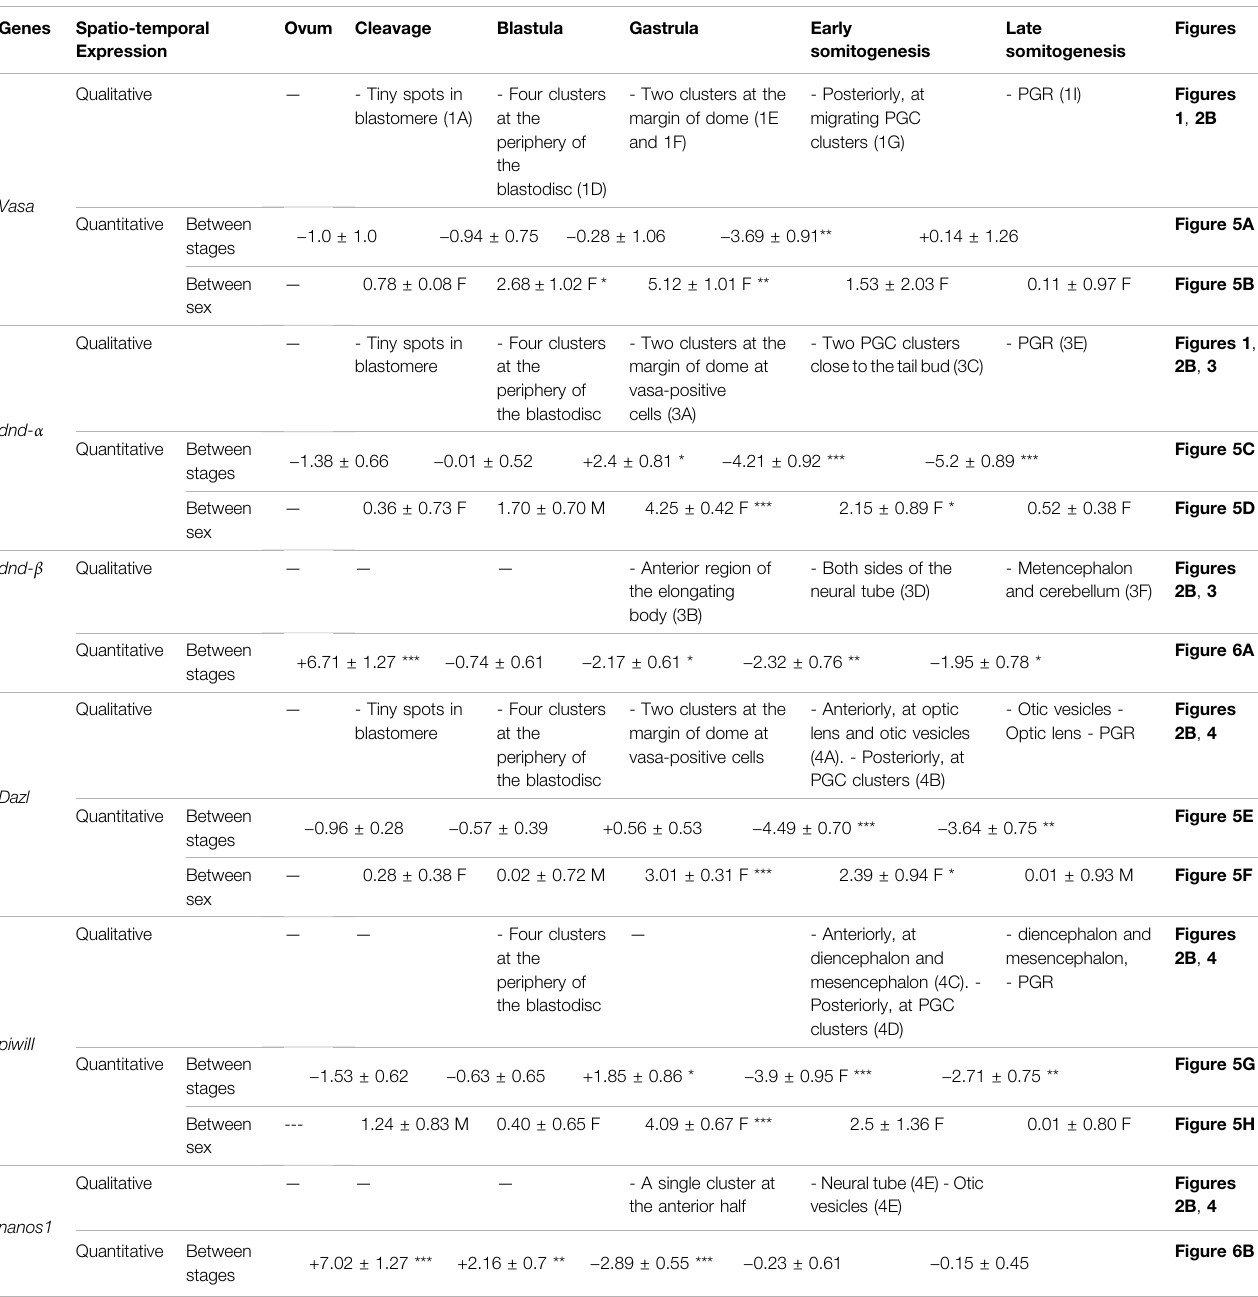
TABLE 1 | Spatio-temporal expression of PGC-speci fi c markers at select embryonic stages of G. holbrooki